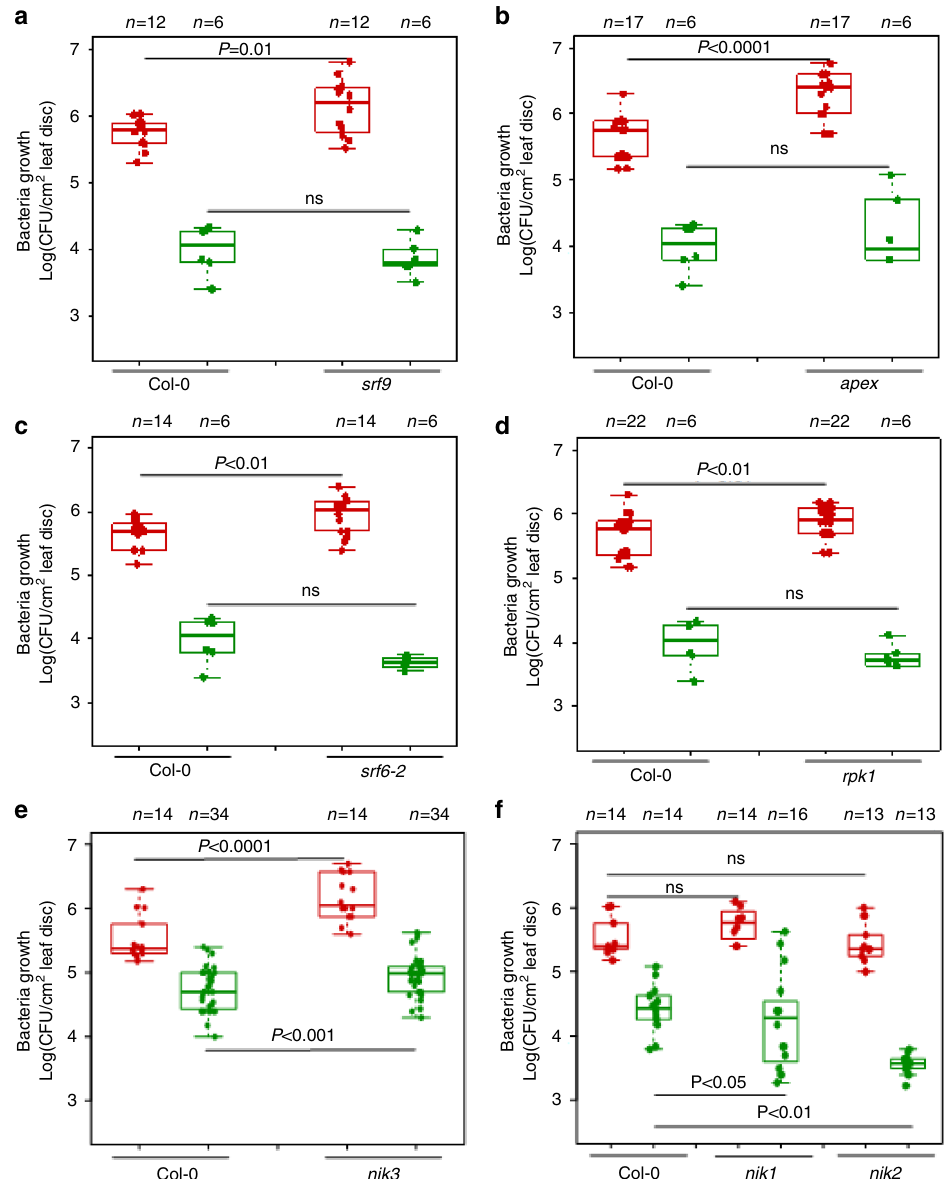
Fig. 5 Immune-related functions of novel LRR-RKs in CSI LRR . Bacterial growth of Pseudomonas syringae pv. tomato DC3000 ( Pto DC3000, red bars) and effectorless mutant strain Pto DC3000 hrcC − (green bars) were quanti fi ed 3 days after syringe inoculation (OD 600nm = 0.0002) on srf9 ( a ), apex ( b ), srf6-2 ( c ), rpk1 ( d ), nik3 ( e ), and nik1 as well as nik2 ( f ). Wild-type Col-0 plants were used as controls. Each dot in the box and whisker plot represents individual data points. n shows the number of leaf samples, and each sample contains four biological independent leaf discs. One-way ANOVA was performed to estimate statistical signi fi cance for bacteria growth. n.s. stands for not signi fi cant. * P < 0.05, ** P < 0.01 and *** P <